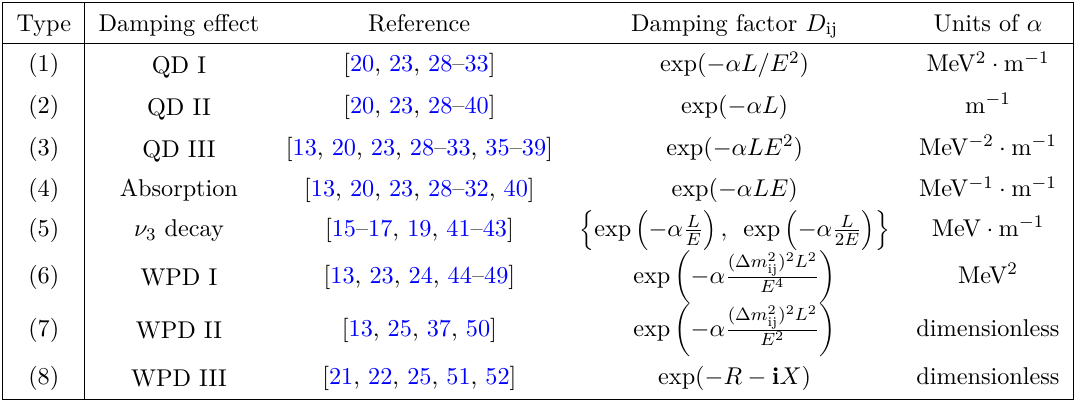
Table 1. List of new physics models with different exponential damping factors. The definitions of the parameters in the type (8) model are given in eq.